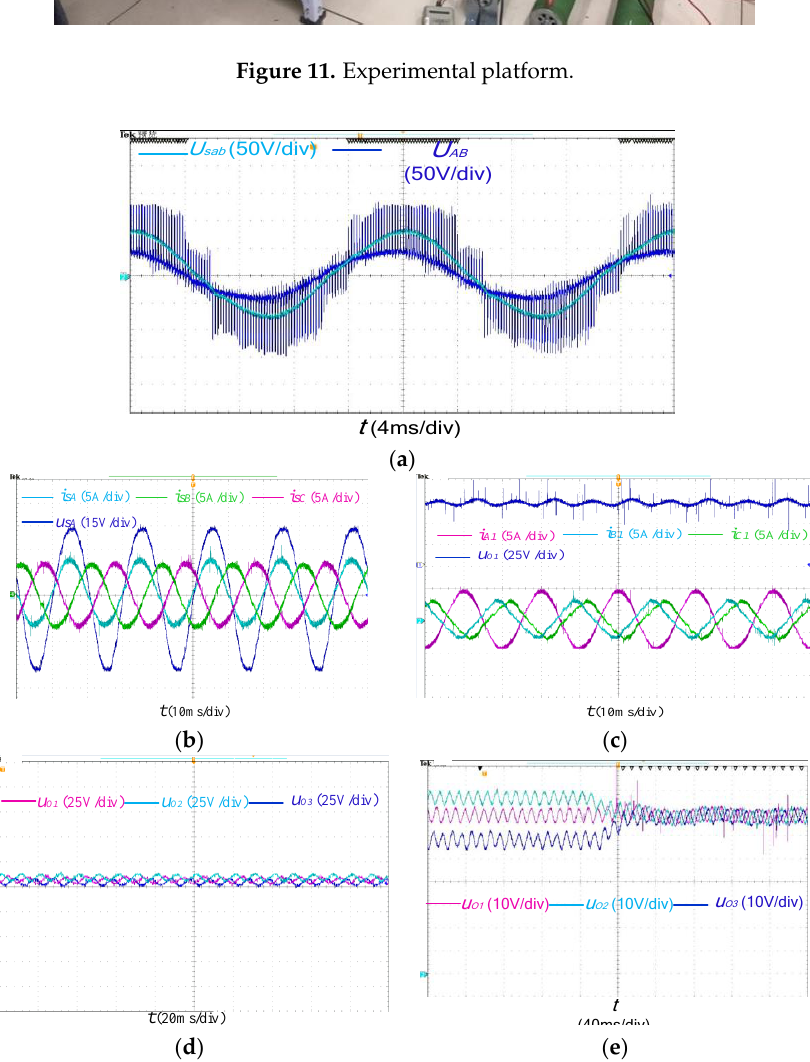
Figure 12. Experimental waveforms. ( a ) the line-line voltage between two VIENNA units. ( b ) the grid line currents. ( c ) the ac-side currents and the dc-link voltage of VIENNA unit 1. ( d ) three dc-link voltages in balanced loads. ( e ) three dc-link voltages in unbalanced loads.